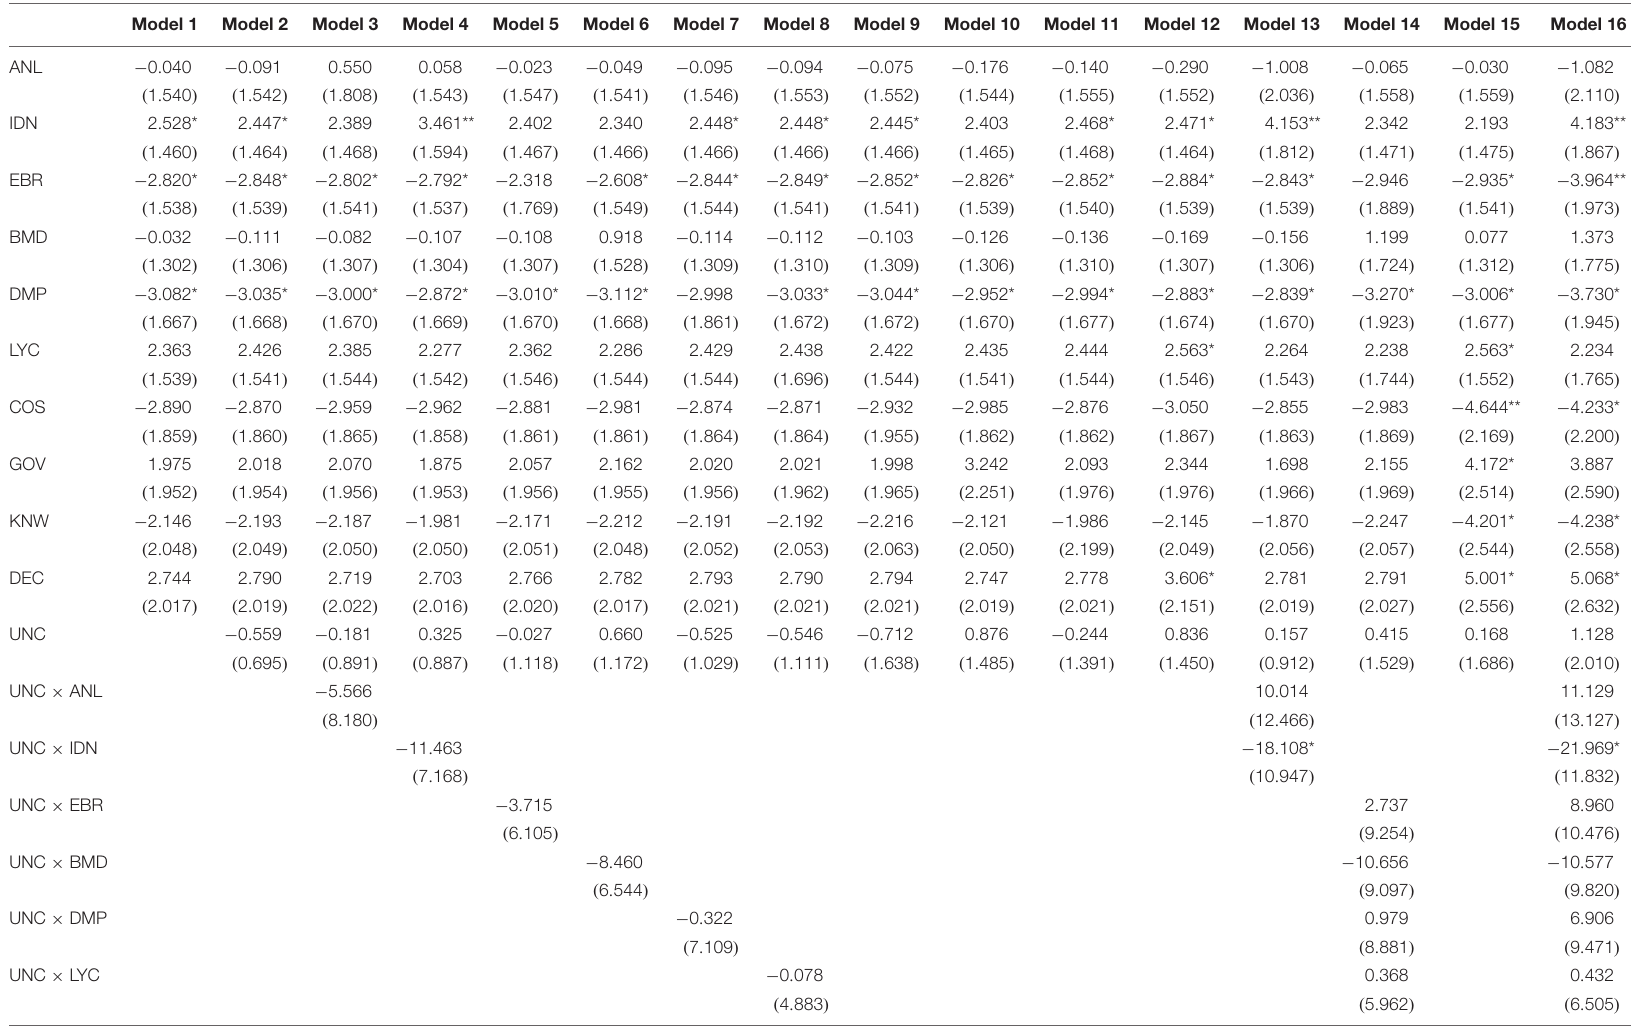
TABLE 5 | Fixed effect panel model estimation of the impact of DCV and environmental uncertainty on